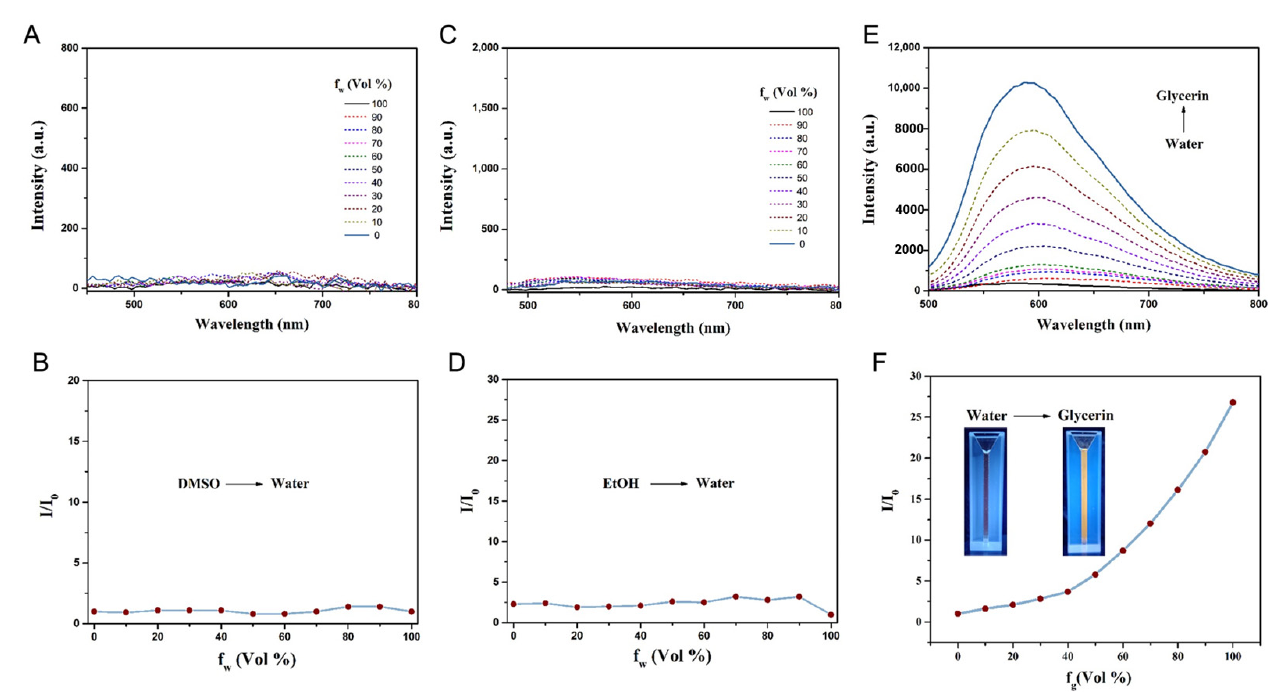
Figure 1. AIE spectra of QM-SS-KK in various solvents of different water fractions ( f w ). Emission spectra of QM-SS-KK (10 × 10 − 6 mol/L) in DMSO-water system ( A ), EtOH-water system ( C ), and glycerin-water system ( E ) ( λ ex = 455 nm). I / I 0 plots of QM-SS-KK ( B , D , F ). I refers to the fluorescence intensity of fluorophore at 590 nm. I 0 refers to the fluorescence intensity of fluorophore in 0% of water for ( A ) and ( C ), and 0% of glycerin for ( E ).